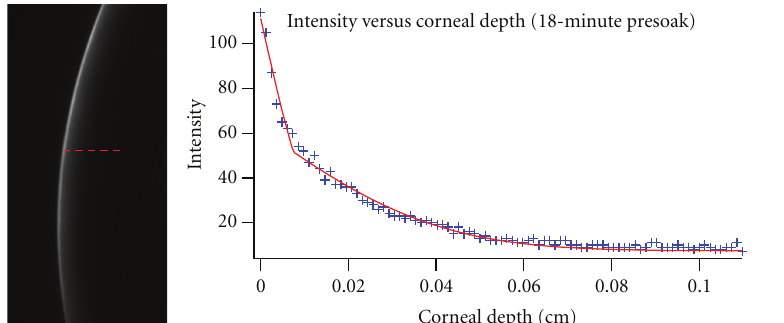
Figure 5: The image on the left shows the intensity profile after 18 minutes of presoak with 0.1% riboflavin in 0.44% saline, 0.02% BAK. The corresponding plot on the right shows the intensity versus the corneal depth (blue marker) and the biphasic curve fit to the experimental data (red line).